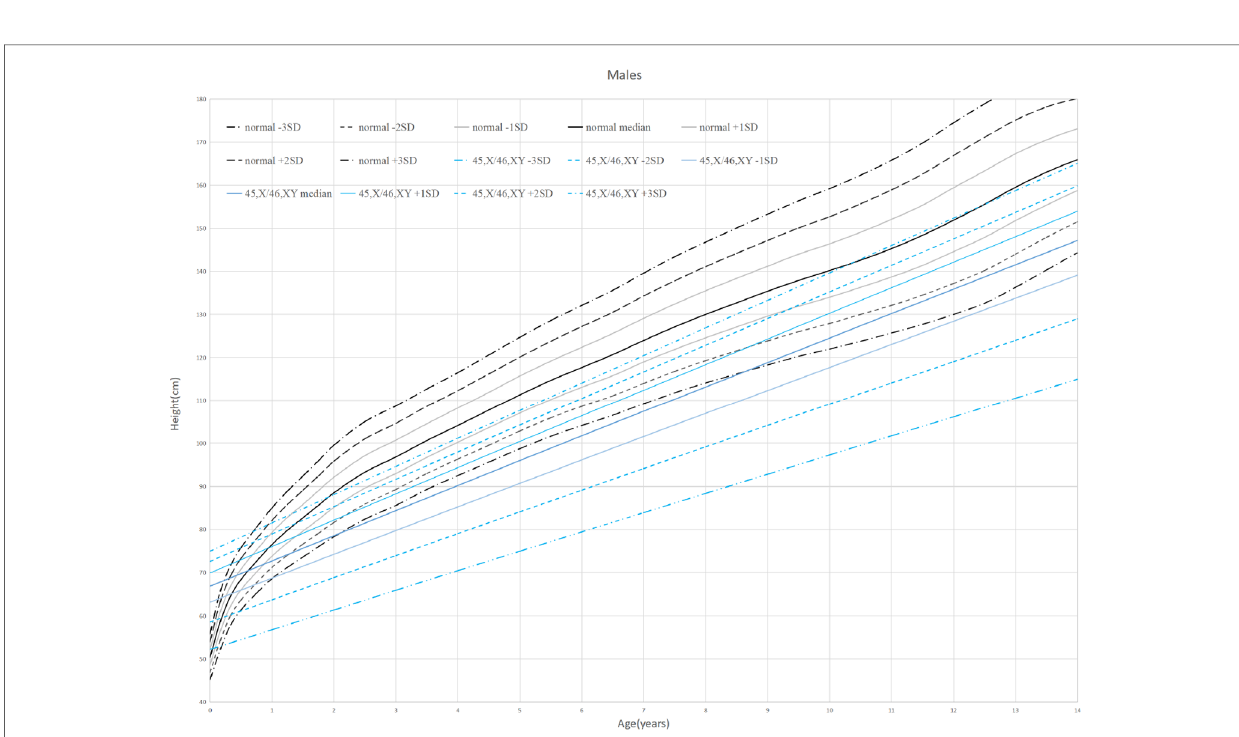
FIGURE 2 Standard deviation height curves of children with 45,X/46,XY mosaicism and normal Chinese boys.